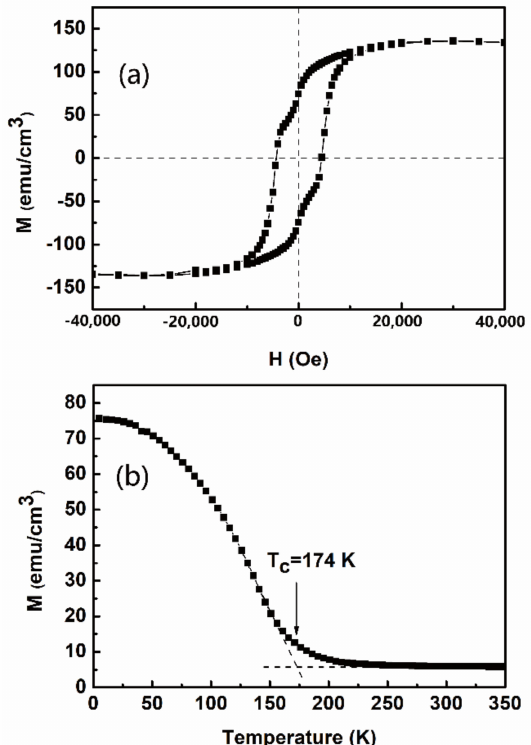
Figure 4. ( a ) The dependence of in-plane magnetization on magnetic field at 5 K, and ( b ) magnetization as a function of temperature at 500